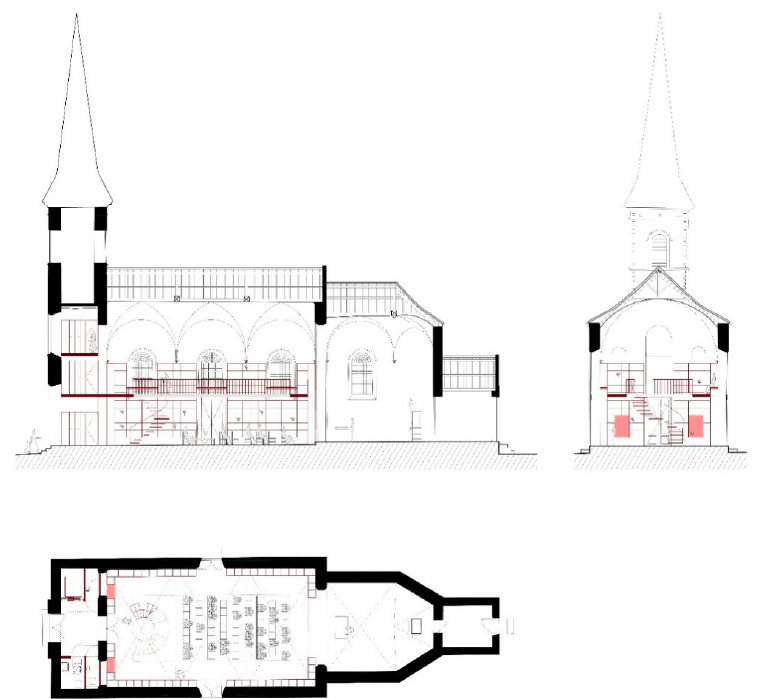
Figure 4. Columbarium church of St. Odulphus: floorplan ground floor with longitudinal and transverse section.